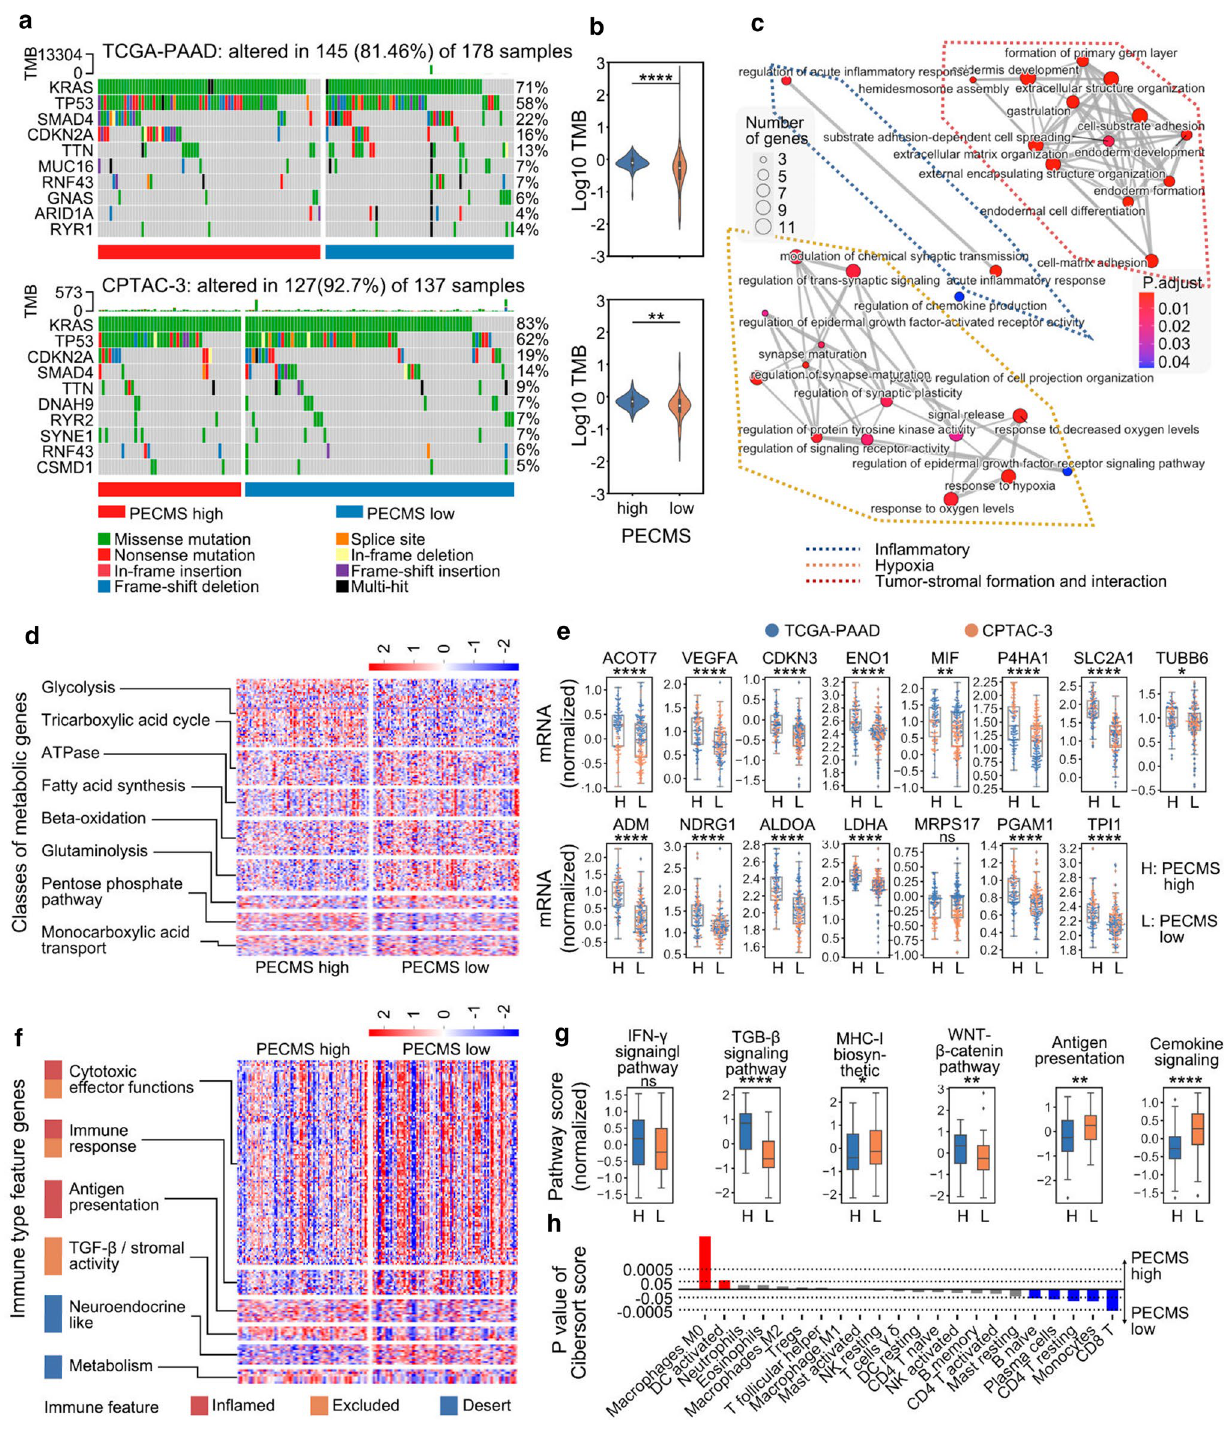
Fig. 3 Microenvironment characteristics of patients in different PECMS classes ( a Mutations in patients in different PECMS classes in TCGA- PAAD or CPTAC-3. b TMB of different PECMS classes in TCGA-PAAD or CPTAC-3. c Pathway pairwise enrichment between the PECMS-high and PECMS-low groups. d The normalized mRNA expression of metabolic features. e Different mRNA levels of 15 oxidative stress marker genes. f The normalized mRNA expression of immune feature genes. g The normalized pathway GSVA scores in different PECMS groups. h P value of CIBERSORT scores between different PECMS groups. ns: no significant difference; *: P < 0.05; **: P < 0.005; ***: P < 0.0005; ****: P <